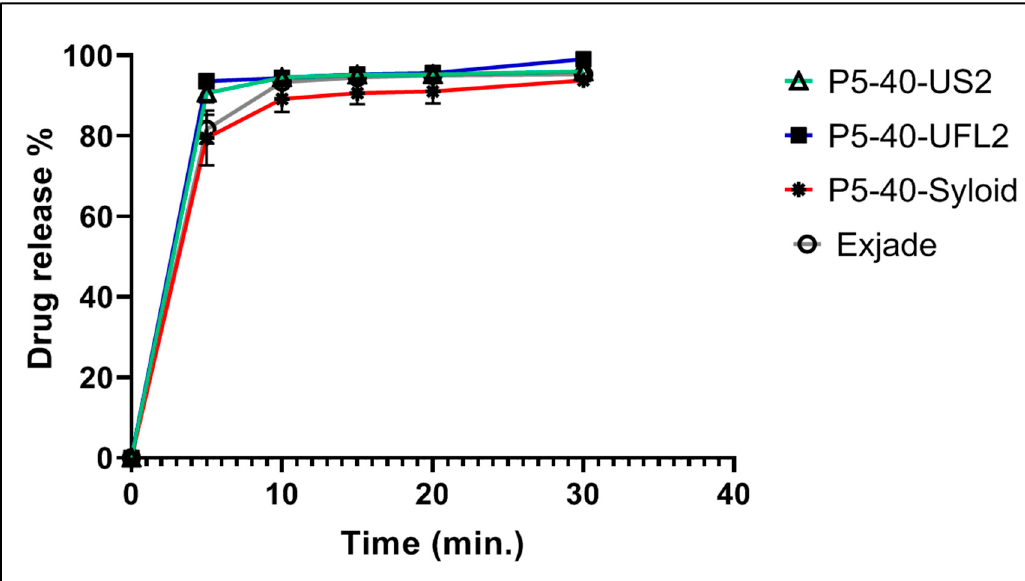
Figure 9. Drug release % of DFX from optimized S-SNEDDS formulated with different carriers and its commercial tablet (Exjade ® ) in phosphate buffer of pH 6.8 containing 0.5% Tween 20 (dissolution media recommended by the FDA). The data represent drug release (%) versus time (in min) in terms of mean ± SD ( n = 3) ( p < 0.05).